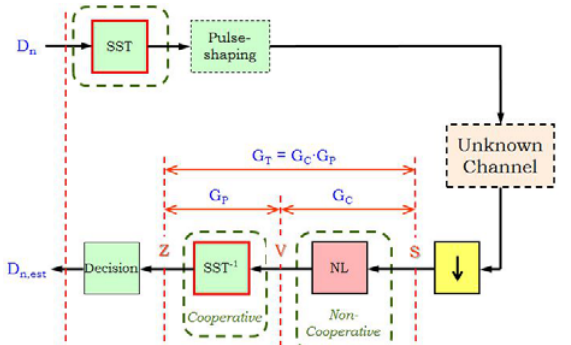
Fig. 2. Generic structure of an efficient communication complex with integrated interference reduction. SST ... spread-spectrum technology, NL ...